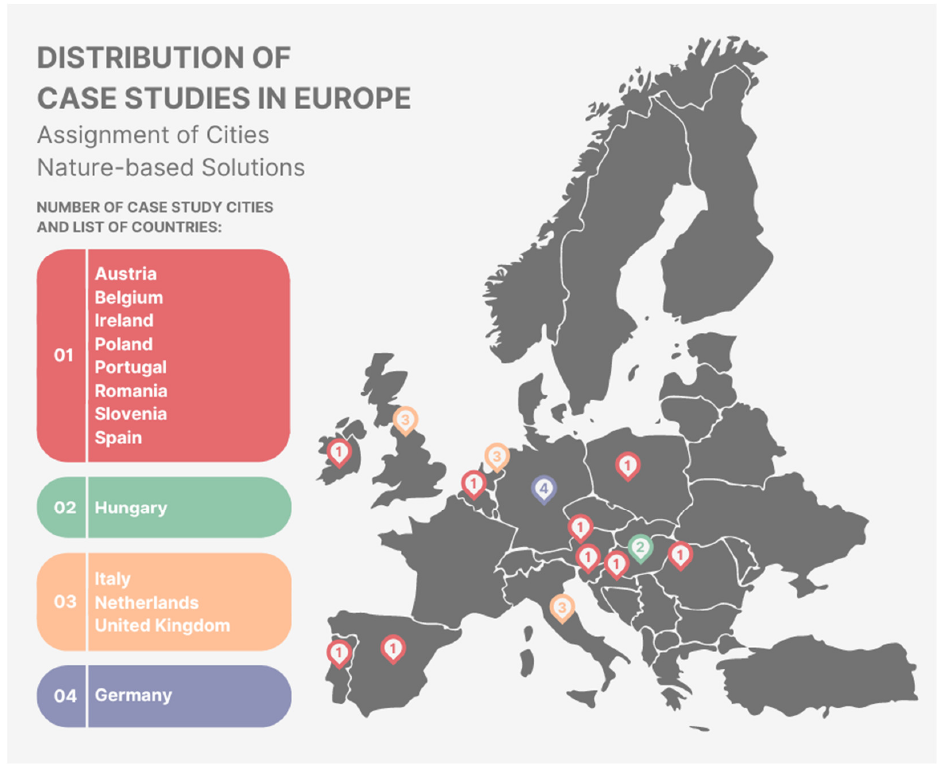
Figure 2. Spatial distribution of cities by country.